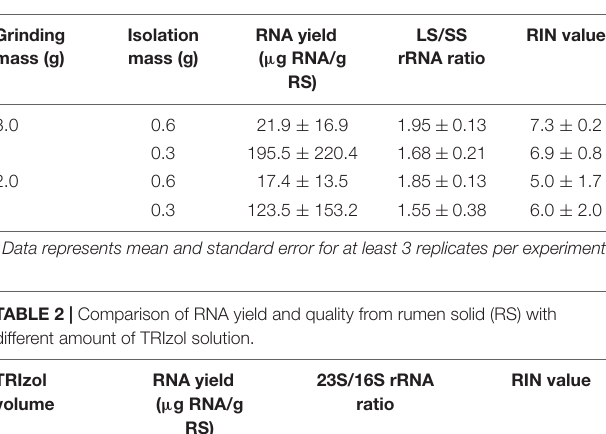
TABLE 1 | Comparison of RNA yield and quality from rumen solid (RS) with different initial grinding masses and different masses used for RNA isolation.